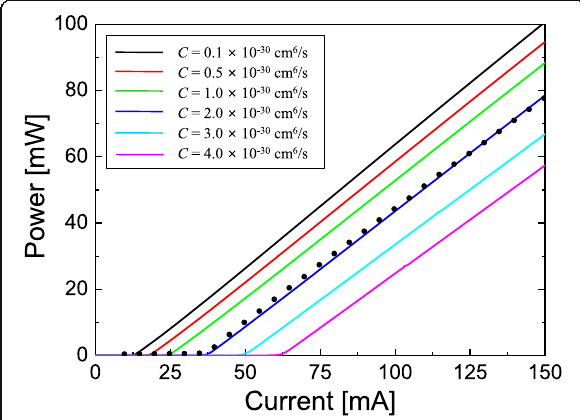
Fig. 2 L - I curves of the simulated LD structures for various Auger recombination coefficient ( C ) values from 1 × 10 − 31 to 4 × 10 − 30 cm 6 / s at 20 °C. Here, the barrier thickness and doping concentration are fixed at 10 nm and 1 × 10 17 cm − 3 , respectively. The L - I curve of the reference LD is represented as solid dots